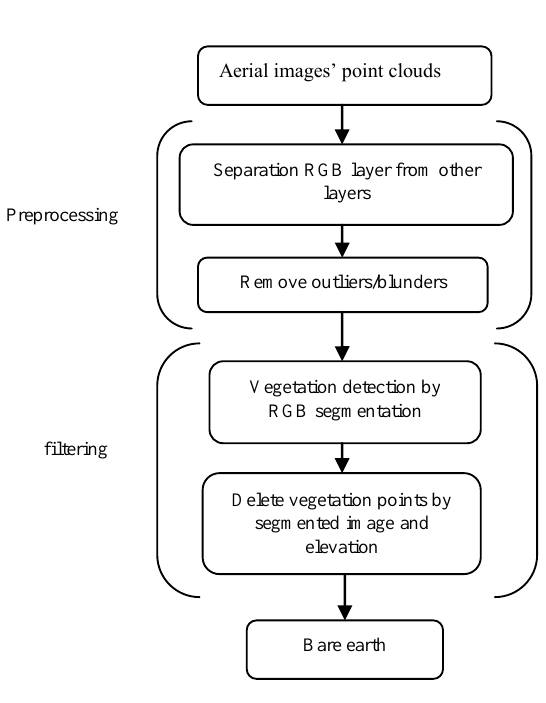
Fig 2. diagram of point clouds filtering